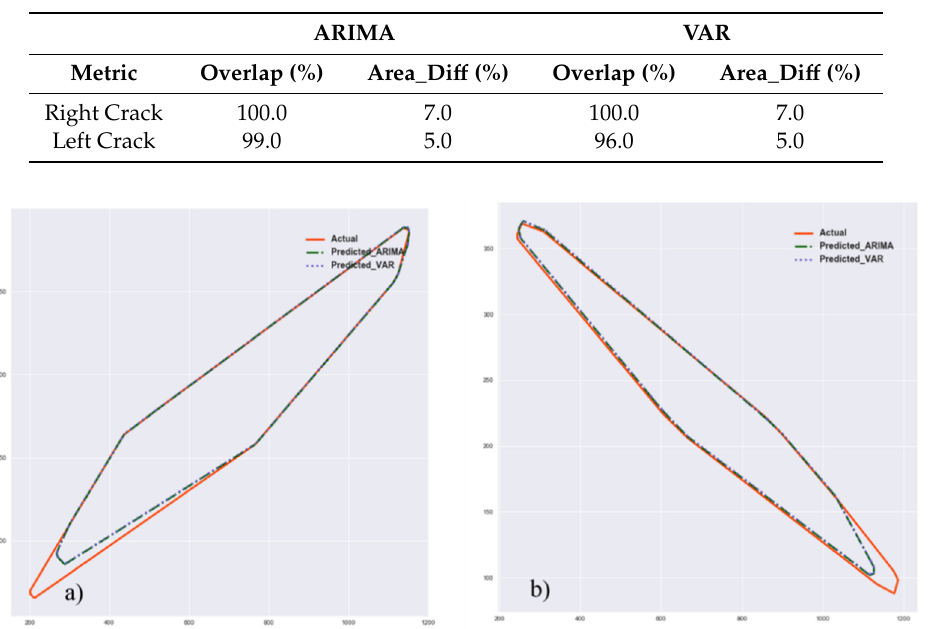
Figure 9. Comparison of the predicted crack shape against the ground truth for ( a ) right and ( b ) left